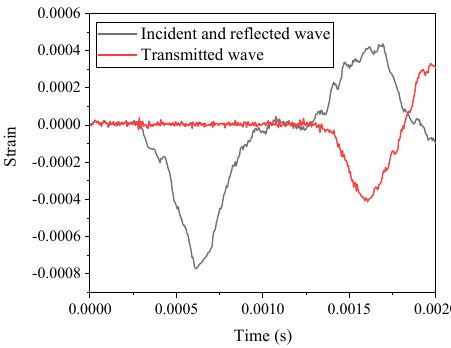
Figure 3. Typical waveforms of incident, reflected and transmitted pulses with a pulse shaper. The stress-strain curve of each mixture can be obtained by inputting the incident pulse ( ε (t) ) and transmission pulse ( ε (t) ). Tri-wave method was used to calculate the reflected pulse ( ε (cid:2928) (cid:2930) (t) ), strain ( ε (t) ) and strain rate ( ε(cid:4662) (t) ) [34–36]. stress ( σ (cid:2929) (cid:2929) (cid:2929) 2.4.3. SEM Test The SEM test (Ultra-plus SEM, Jena, Germany) was performed on the fracture pieces after SHPB test to explore the damage morphology of PP fibre. The selected pieces were coated with a gold film before the test. Regarding the image acquisition parameters, the working distance for the SEM test was set in the range of 11.4 to 31.8 mm, while the acceleration voltage was 15 kV. The magnification was in the wide range of 200×. 3. Results and Discussion 3.1. Workability The slump value is normally used to represent the workability of concrete. Figure 4 shows the slump value of all mixtures. It is clear that the slump value of all mixtures was significantly influenced by the PP fibre content. The slump value decreased sharply with increasing PP fibre content in the mixture, which agreed well with the previous studies [3,18,37]. The slump value of PP09, PP18, PP27 and PP36 reduced 14.6%, 20.6%, 36.0% and 47.1%, respectively as compared to the reference mixture (PP00) with a slump value of 184.7 mm. The reduction in workability can be ascribed to the following reasons: (1) adding fibres into the concrete matrix resulted in the increase of viscosity especially when the surface area of fibres are larger [18]; (2) PP fibres exhibit hydrophobic characteristic in nature (i.e., repelling water) and therefore the compactness of mixtures reduced with increasing PP fibre content; (3) clogging of PP fibres would occur, which may affect the uniform dispersion of the fibres in the concrete mixtures [38]; and (4) the internal microstructure of mixtures would be changed due to the addition of PP fibres and thus restrict the flow of mixtures [9]. Since the compactness of concrete may affect its mechanical properties, the dosage of SPs should be adjusted accordingly in order to ensure that all PP fibre reinforced concrete mixtures are workable.